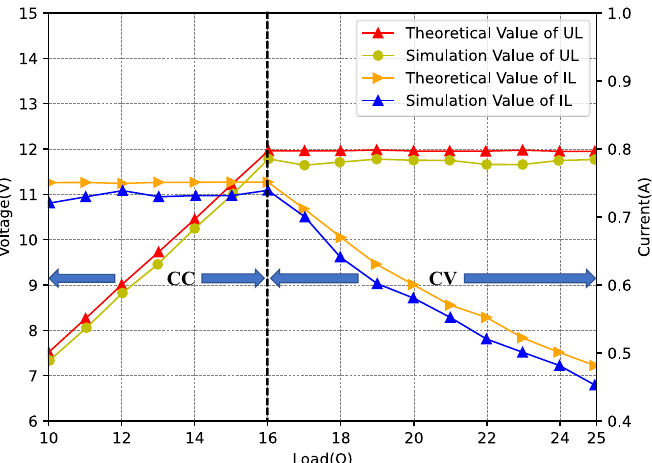
Figure 10. Comparison between simulation results and theoretical values of CC-CV output of the WPT system based on Simulink.